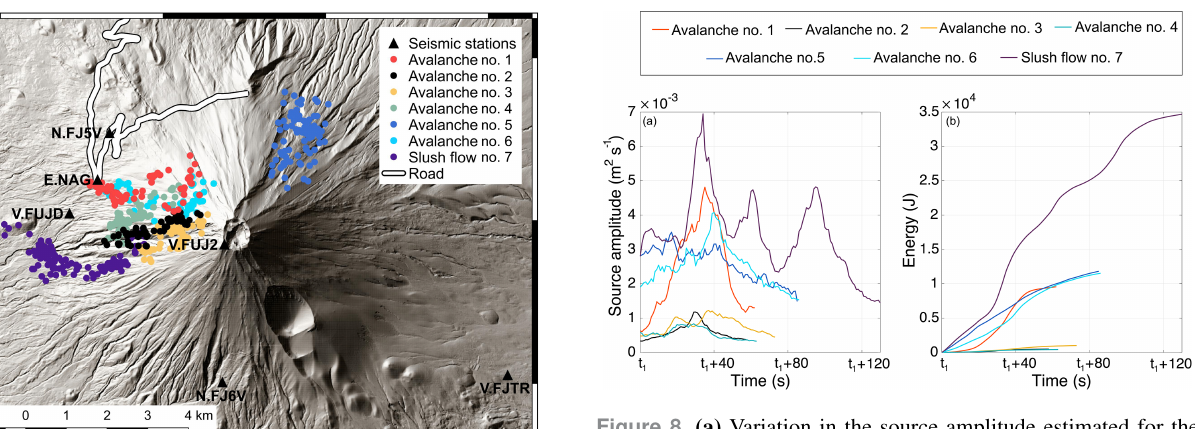
Figure 8. (a) Variation in the source amplitude estimated for the seven events as a function of time from the start time of the track- ing window ( t 1 of Table 3). (b) Temporal variation in the radiated seismic